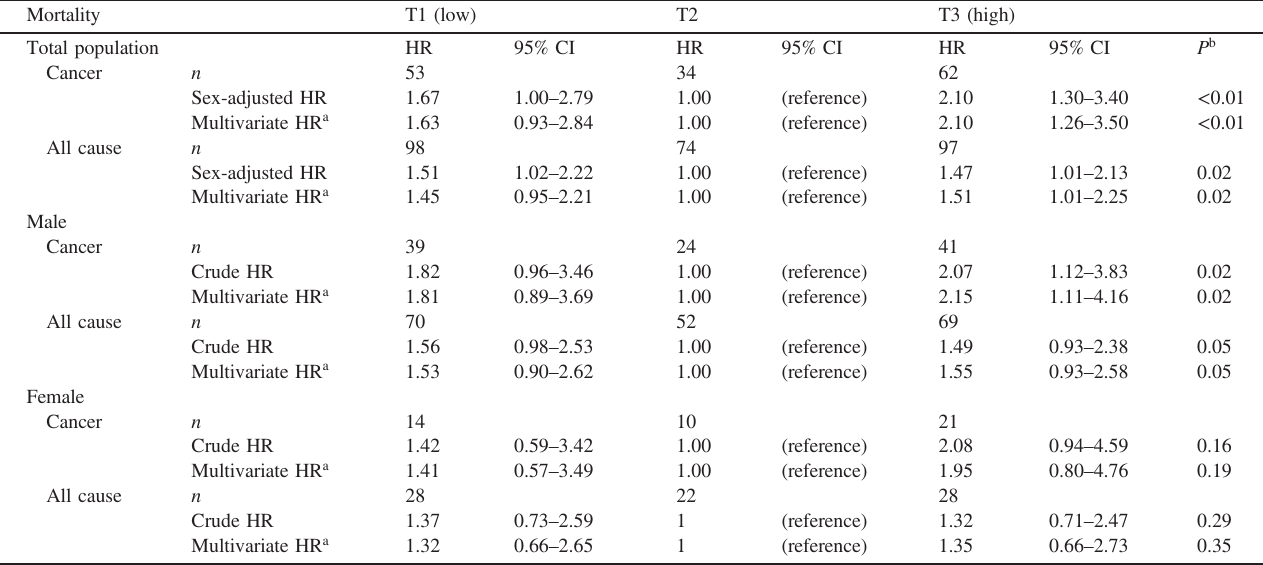
Table 2. Association of total adiponectin with cancer and all-cause mortality Mortality T1 (low) T2 T3 (high) Total population HR 95% CI HR 95% CI Cancer